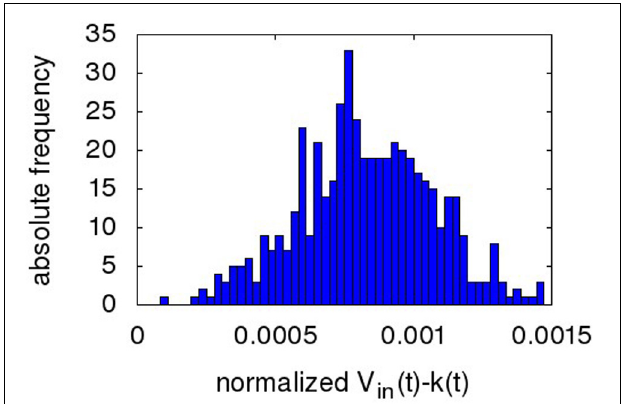
FIGURE 8 | INL of ramp portion of the waveform in Figure 6 (relative to the normalized full swing). The ideal INL based on the transfer curve of Equation 3 is also displayed (black,